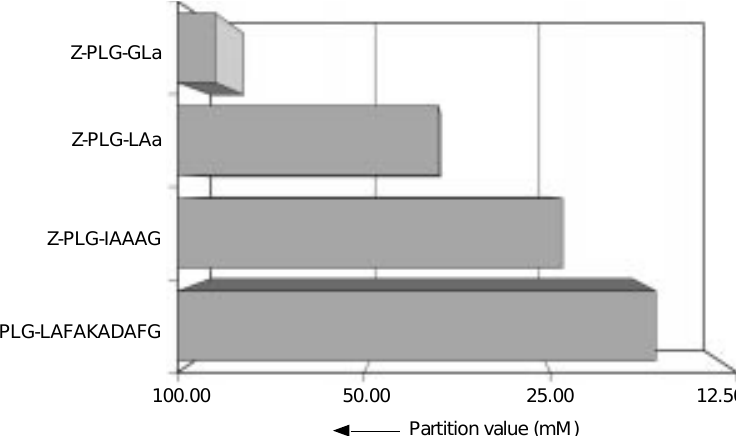
Figure 7 - Partition values of V8 protease-catalyzed peptide coupling using Z-Pro-Leu-Gly- SCm as acyl donor (32). Conditions: 0.2 M HEPES-buffer, pH 8.0, 37 o C; [acyl donor]: 2